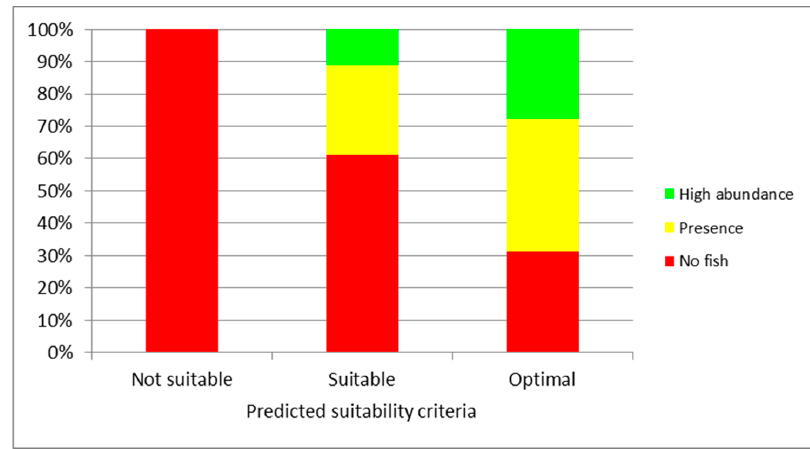
Figure 6. Comparison between results of the conditional habitat suitability criteria (CHSC) model and results of bullhead sampling in the Stura di Demonte. The x-axis shows predicted suitability criteria in three different classes: not suitable, suitable and optimal. Fish presence class is shown by colors.